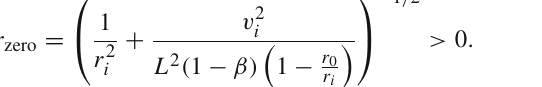
Fig. 3 The profile of radial outwards ( + sign) and radial inwards ( − sign) geodesics of Eq. (17) are plotted in a . Both start from r i = 4 with initial velocity v i (cid:11)= 0 at τ = 0 ( r 0 = 2). The radial outwards geodesic (the upper curve) reaches infinity, while the inwards one reaches r 0 at a finite time, ending up with a zero velocity, since d r lower curve). In b radial outwards (the upper curve) and radial inwards (the lower curve) geodesics of Fig. 3a are plotted. Both particles start to move at r i = 4 with initial velocity v i = ± 3 ( r 0 = 2). For the radial inwards geodesic ( v i = − 3) the particle reaches the throat with zero velocity, while for the radial outwards geodesic ( v i = 3) we have √ v → v = 3 2 max